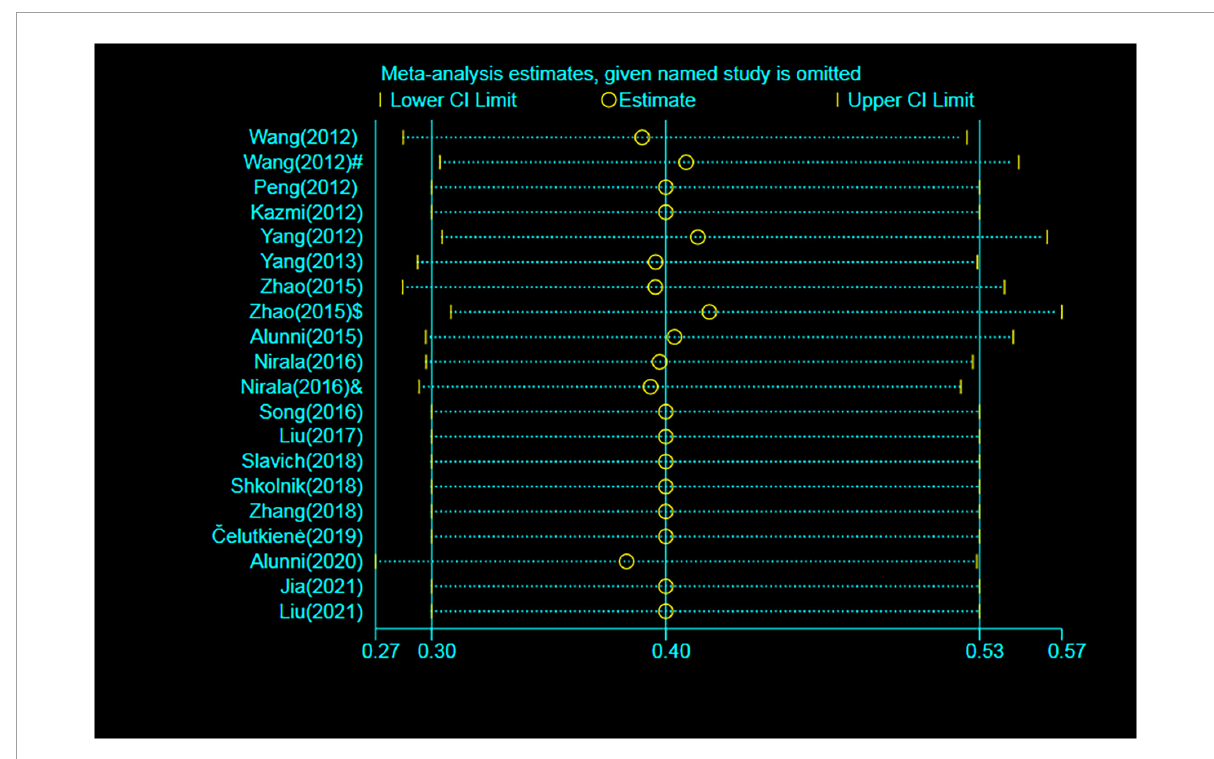
FIGURE6 Sensitivity analysis for MACEs. MACE, major adverse cardiac event; RR, relative risk; CI, confidence interval. # Patients treated with short-term regimen of CSWT; $ , patients treated with an expanding scope CSWT; and & , patients with long-term